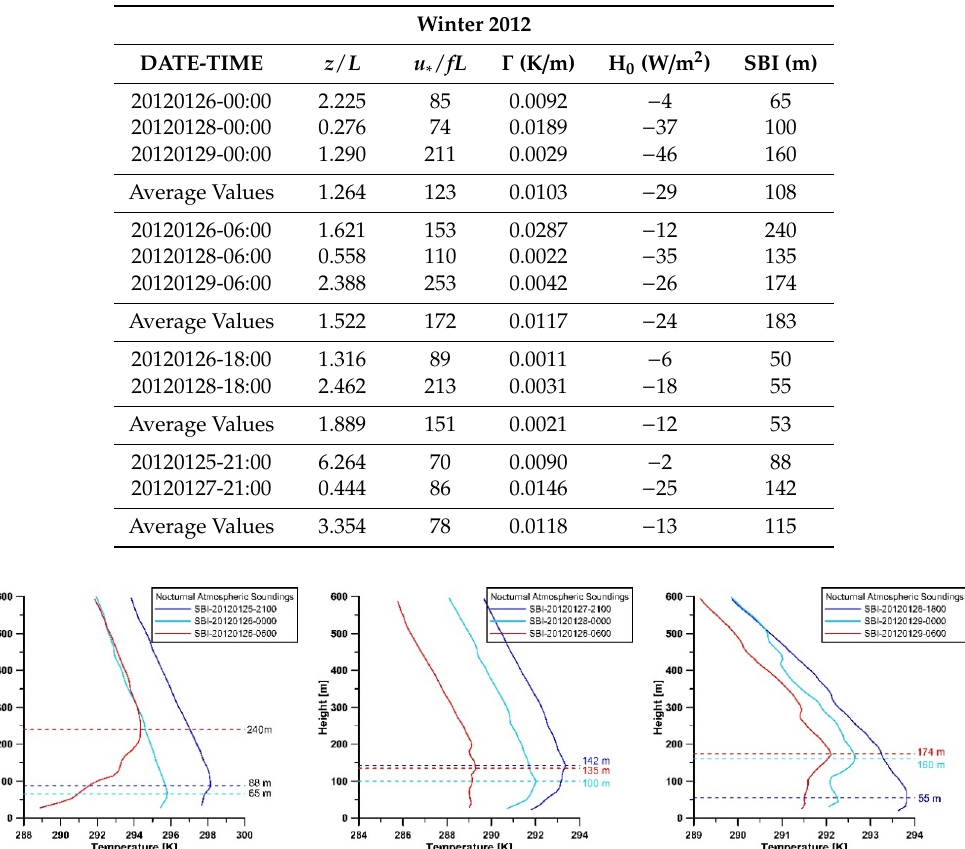
Table 8. The nocturnal stability conditions of the Mexicali Valley during the winter 2012 campaign. The height of the stable boundary layer (SBL) estimated from surface-based inversion.